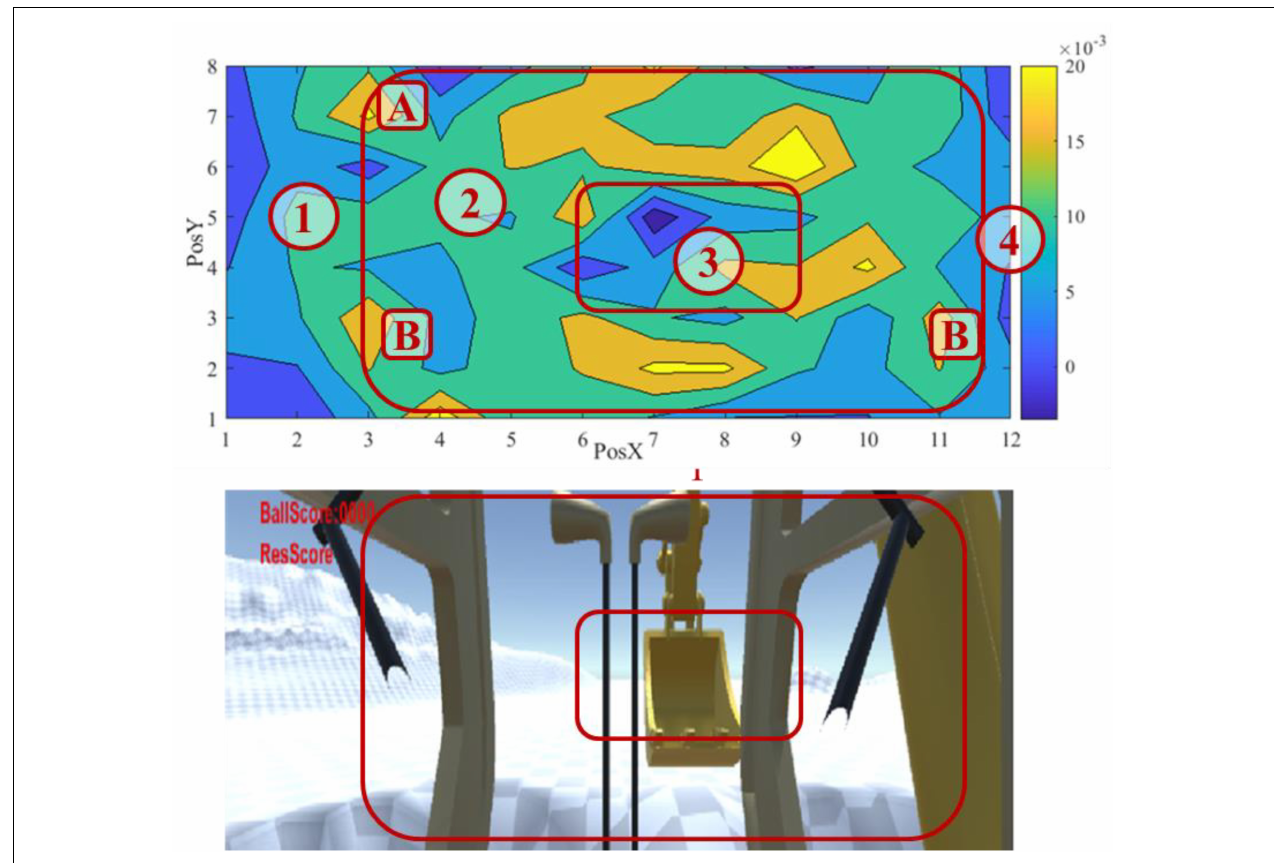
FIGURE 10 | Visual attention map and corresponding